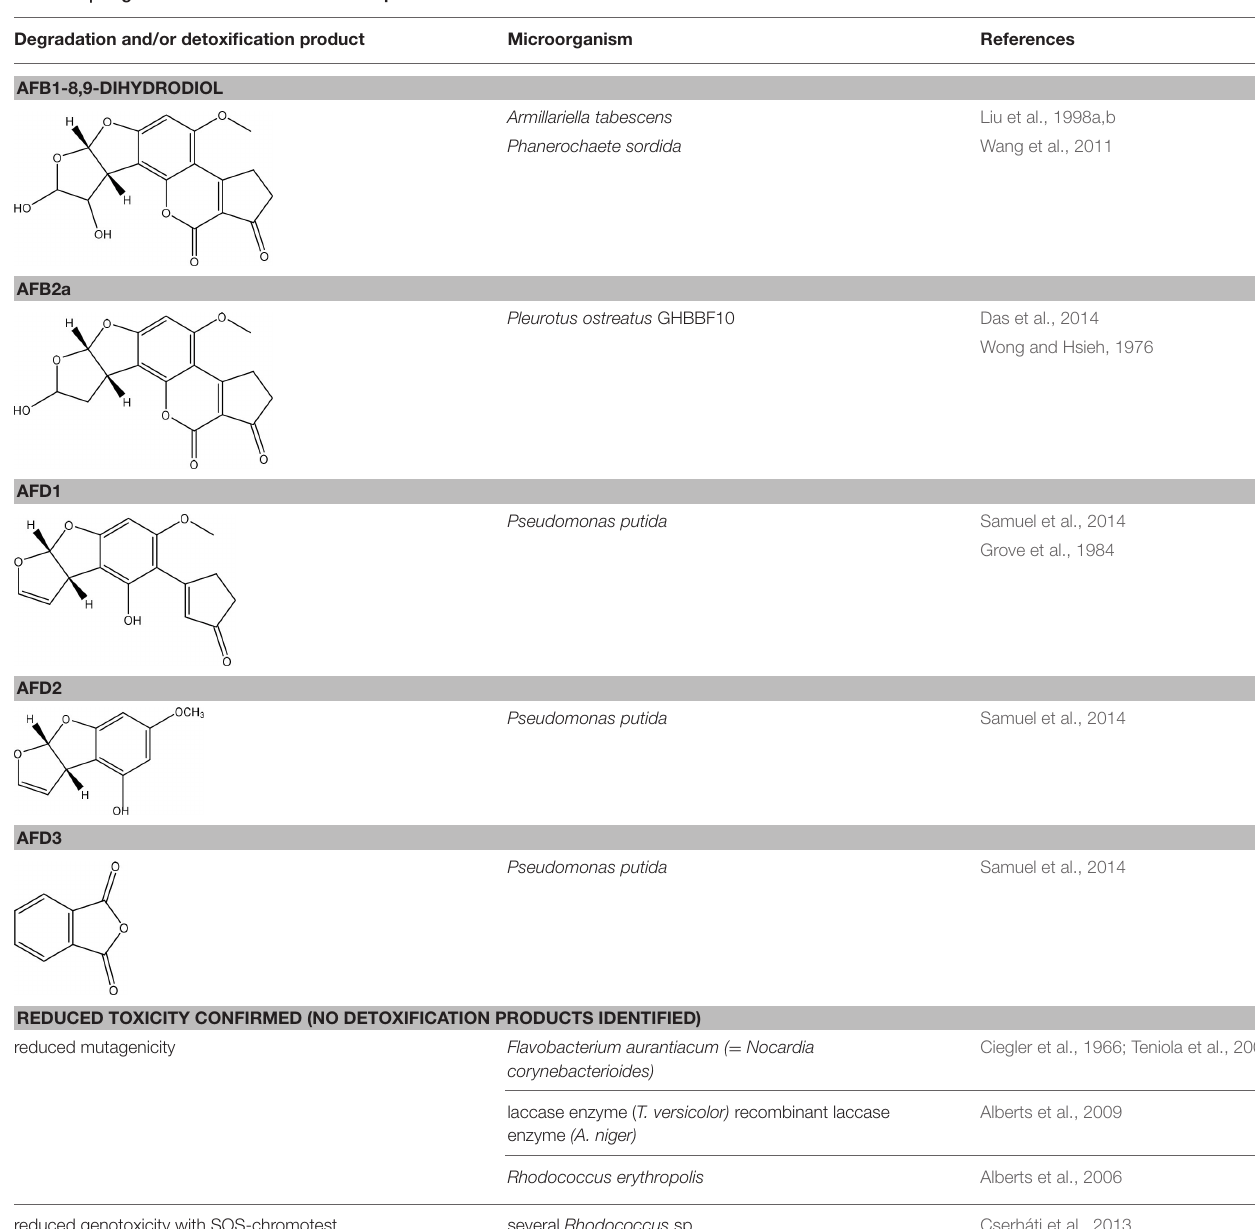
TABLE 6 | Degradation and/or detoxification products of